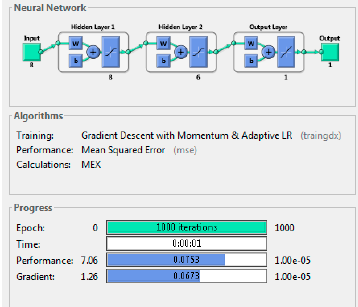
Figure 7. The architecture of the network model in the Matlab neural network training tool.